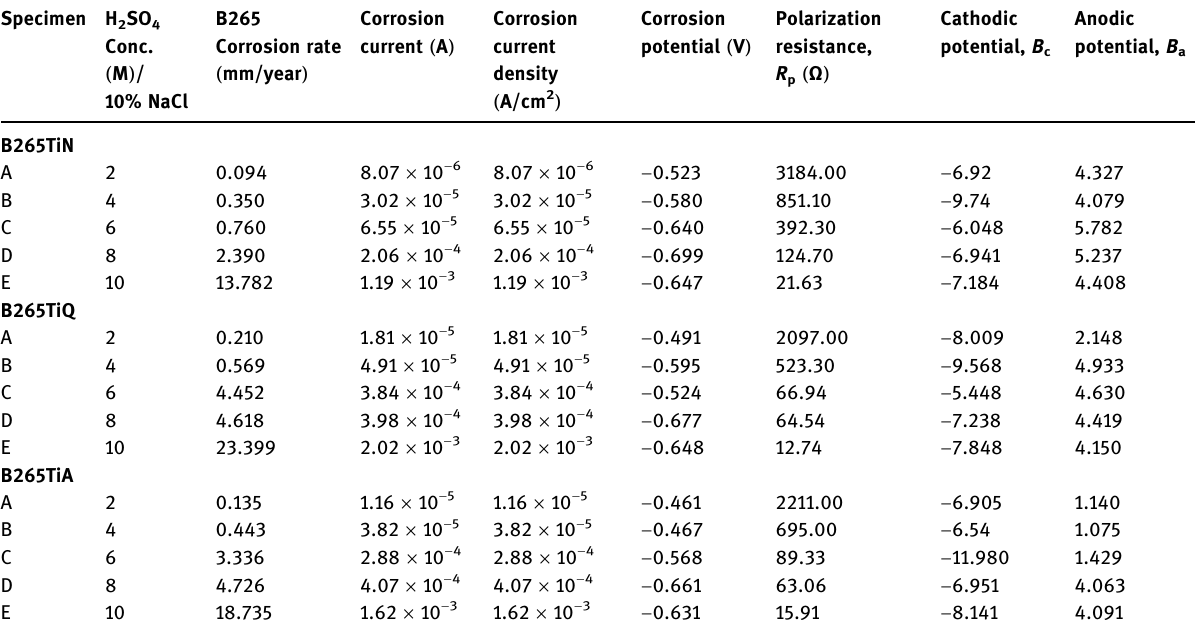
Table 2: Potentiodynamic polarization output for B265TiN, B265TiQ, and B265TiA in 2 – 10 M H 2 SO 4 + 10% NaCl at 30°C Specimen H 2 SO 4 Conc. ( M )